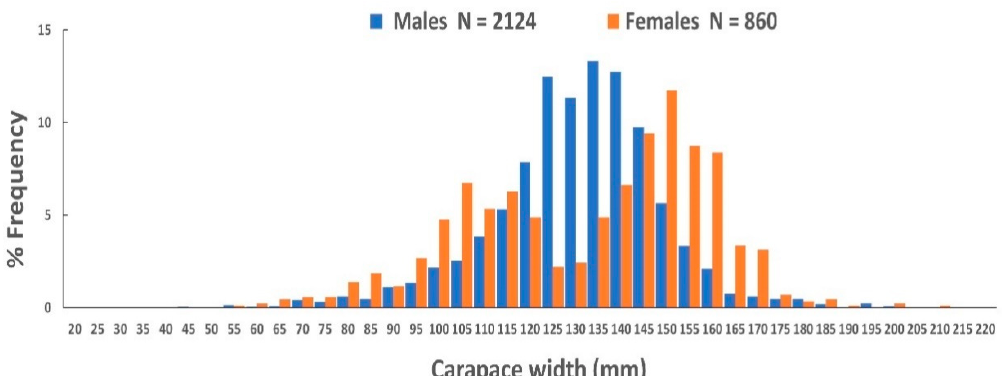
Figure 5. Size–frequency distributions of males and females of the blue crab Callinectes sapidus in the period November 2020–October 2021 in Monolimni Lagoon and the adjacent coastal area. Inside the lagoon, 2034 males and 518 females were measured, with a mean CW ( ± SD) 128.09 ( ± 18.03) mm and 118.43 ( ± 25.49) mm, respectively. The size–frequency distributions were significantly different between females and males (two-sample Kolmogorov–Smirnov test: z = 7.215, p < 0.000). The CW of males was significantly larger than that of females (Mann–Whitney test: U = 392,693.000; z = − 8.958, p < 0.000), with males having a greater median size than females (independent median test: T = 55.66, p < 0.000). In the coastal area, the number of females (N = 342) measured was significantly higher than that of males (N = 90); the mean CW ( ± SD) for males and females was 134.33 ( ± 17.06) mm and 148.30 ( ± 12.94) mm, respectively. The smallest crab was a male (CW = 92 mm), and the largest was a female (CW = 205 mm). The size–frequency distributions were significantly different between females and males (two-sample Kolmogorov–Smirnov test: z = 3.86, p < 0.000). Females were significantly larger than males (Mann–Whitney U = 23,731.5, z = 7.915, p < 0.00), with females having a greater median size than males (independent median test: T = 47.214, p < 0.000).